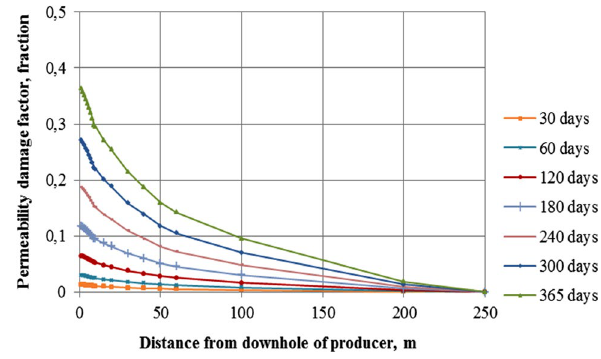
Fig. 12 The permeability damage factor along the radius (r) on the well operation time